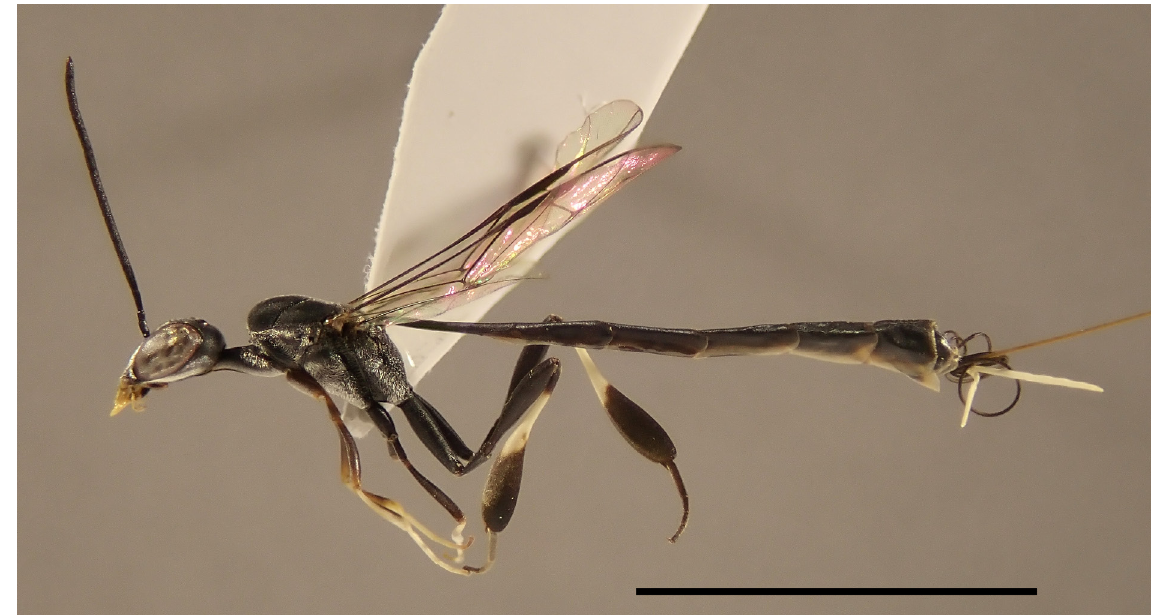
Fig. 7. Gasteruption jenningsi sp. nov., holotype, ♀ (MNHN). Lateral habitus. Scale bar = 5.0